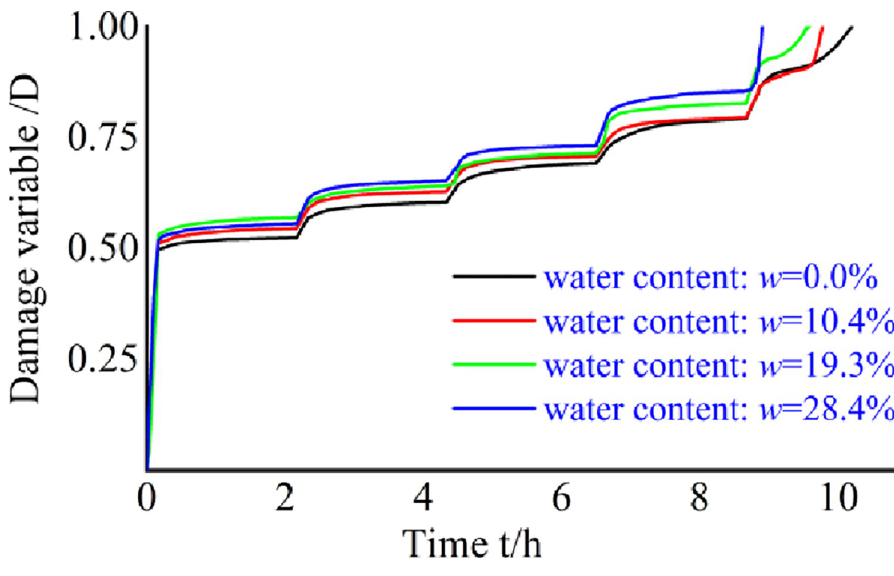
Fig 11. Creep-strain-based damage variable curves.